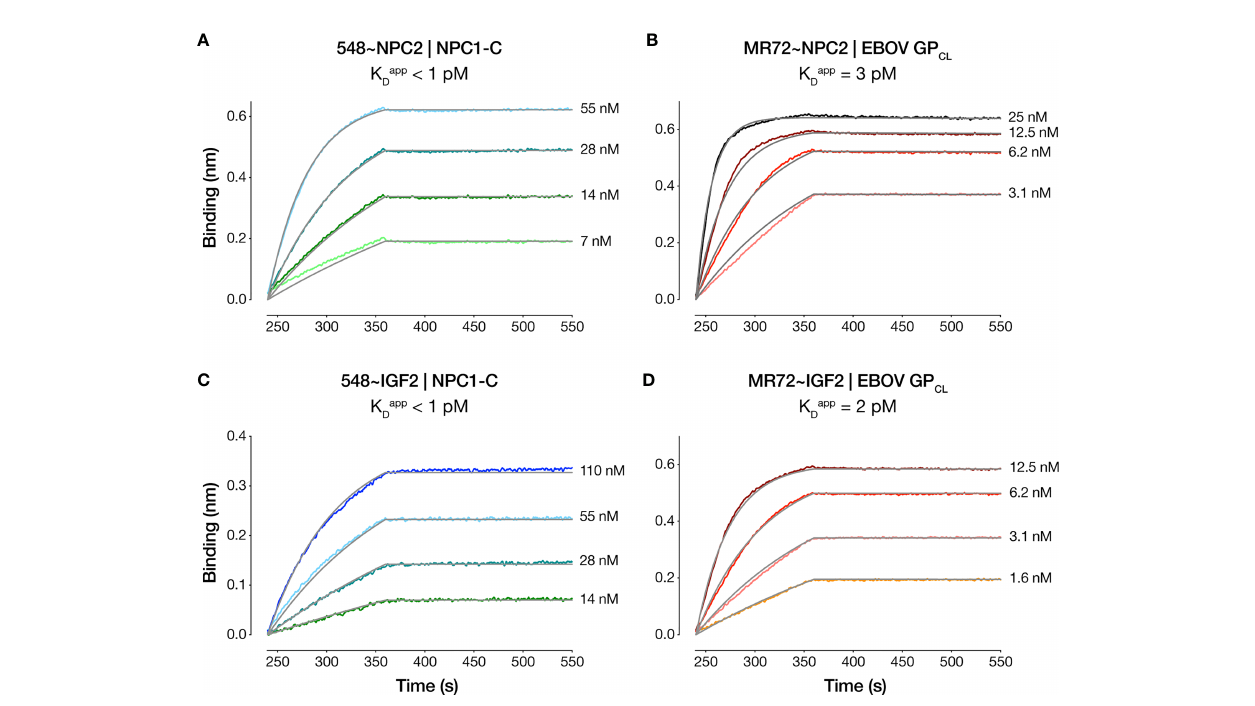
FIGURE 3 | Antibody-antigen binding pro fi les of NPC2- and IGF2-tagged bsAbs. Kinetic binding curves for NPC2- and IGF2-tagged bsAb:antigen interactions were determined by BLI. (A) 548~NPC2 and (C) 548~IGF2 were loaded onto probes and dipped into analyte solutions containing the indicated concentrations of NPC1-C. (B) MR72~NPC2 and (D) MR72~IGF2 were loaded onto probes and dipped into the indicated concentrations of analyte solutions containing EBOV GP CL . Grey lines indicate curve fi ts to a 1:1 binding model. See Table 1 for kinetic binding